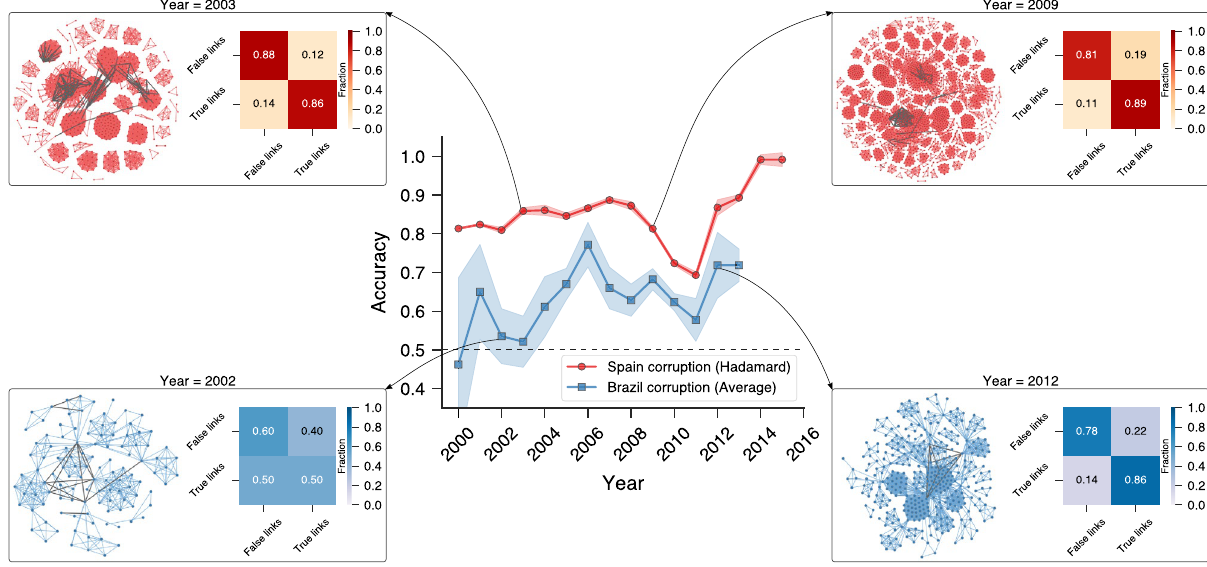
Figure 4. Predicting future partnerships in corruption networks. The central panel shows the accuracy in tasks of predicting future partnerships in the Spanish (red circles) and Brazilian (blue squares) corruption networks created considering scandals occurring up to a given year. The results for the Spanish network use the Hadamard operator, while the ones related to the Brazilian network use the average operator for creating vector representations of edges from the node embeddings obtained with node2vec . The test sets of both networks comprise edges among nodes already present in the network that emerge after the threshold year, and the same number of randomly generated false links that do not appear after the threshold year. The markers represent the average accuracy in the test sets estimated over ten realizations of the embedding and training processes (shaded regions stand for one standard deviation band) for different threshold years. The black dashed line indicates the baseline accuracy. The insets depict network visualizations where the colored edges represent connections among nodes that occurred up to the threshold year, while the gray edges represent the links that will appear after the threshold year. These insets also show confusion matrices associated with the tasks of predicting whether future links are true (rows) or false